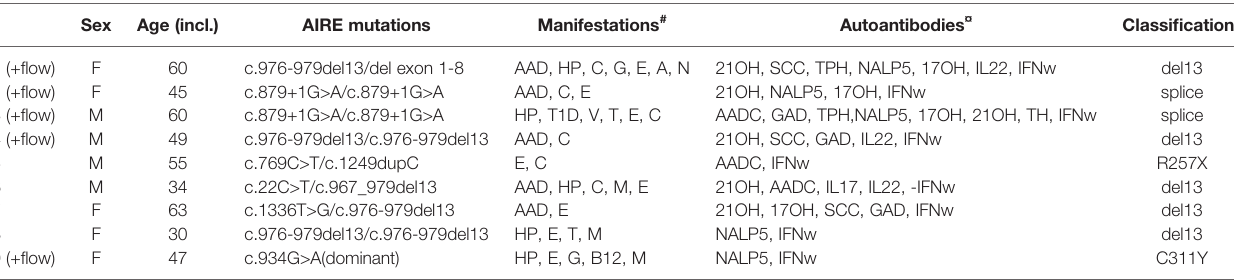
TABLE 1 | Demographics of included APS-1